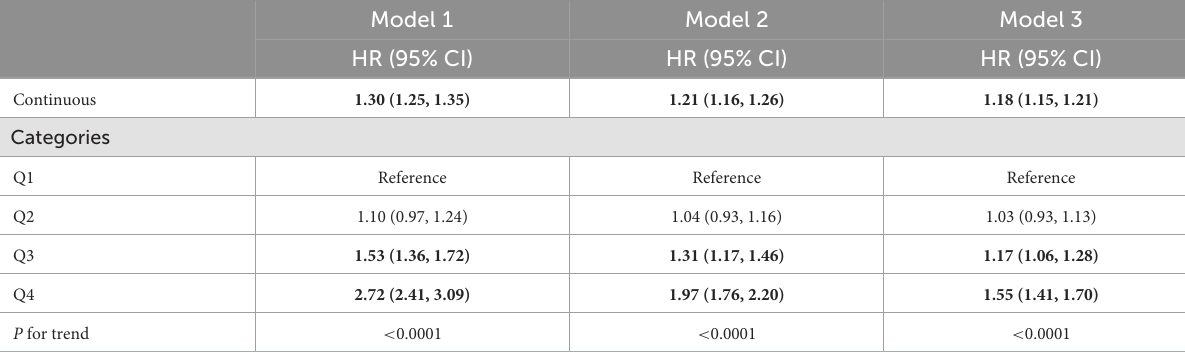
TABLE 2 Risk of all-cause mortality among hypertension patients according to SIRI.